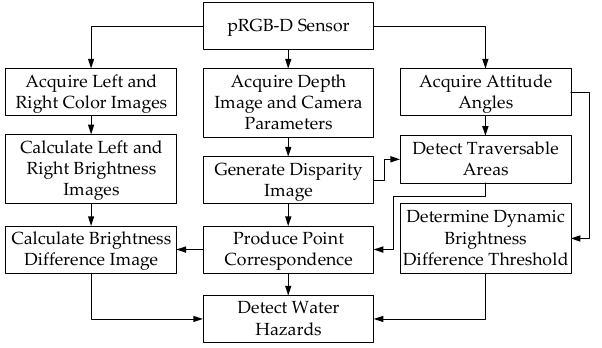
Figure 5. Flow chart of the water hazard detection.